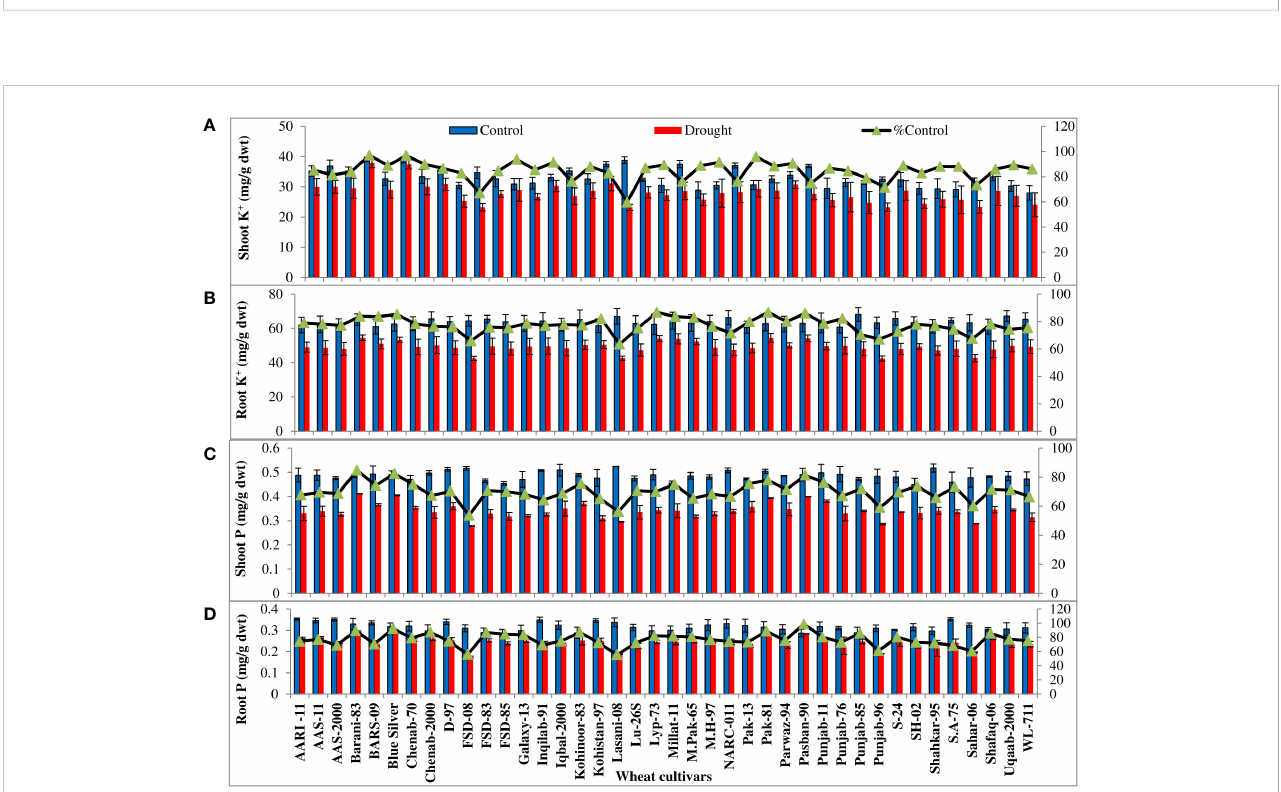
FIGURE 2 Shoot and root K + and P accumulation in wheat seedlings when plants of 40 local wheat cultivars were grown under normal or PEG-induced drought stress for 2 weeks. Means (± SE; n=5) are presented on the primary vertical axis, while percent of the control values is presented on the secondary vertical axis. (A) Shoot K + , (B) root K + , (C) shoot P, and (D) root